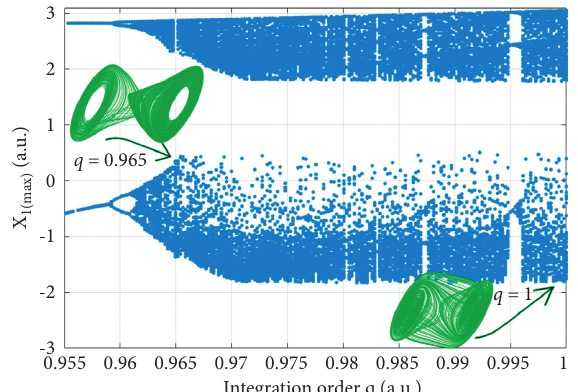
Figure 7: Bifurcation diagram of the Chua system by modifying the integration order, equation (23). The abscissa axis indicates that the three oscillator state variables have the same integration order.